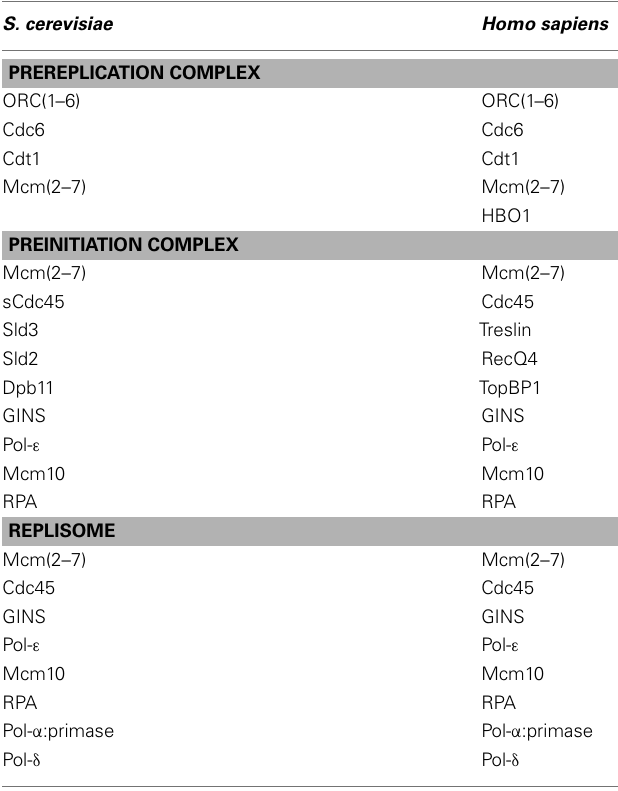
Table 1 | Proteins required for replisome assembly in